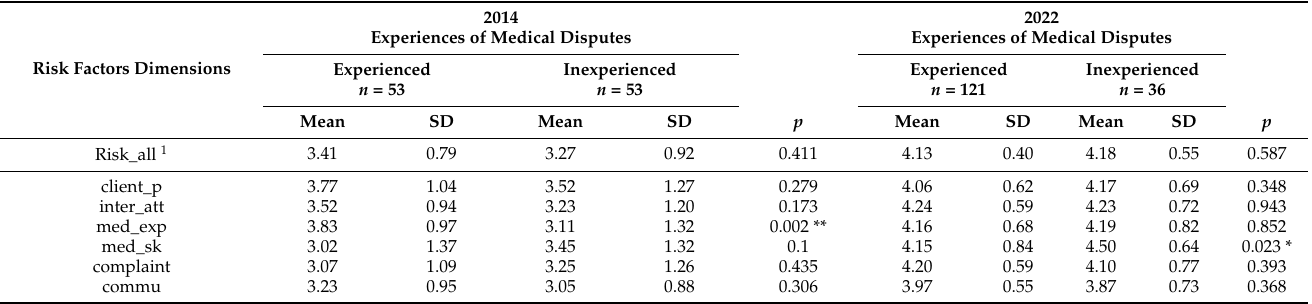
Table 7. The risk factor perception differences in experiences of medical disputes in 2014 and